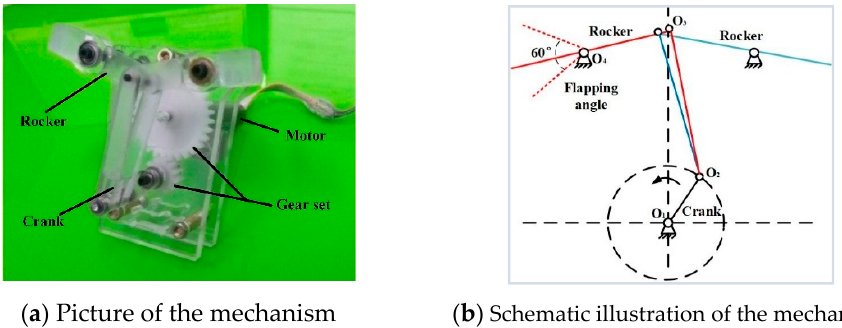
( b ) Schematic illustration of the mechanism Figure 1. Schematic and mechanism of the driven model. Figure 1. Schematic and mechanism of the driven